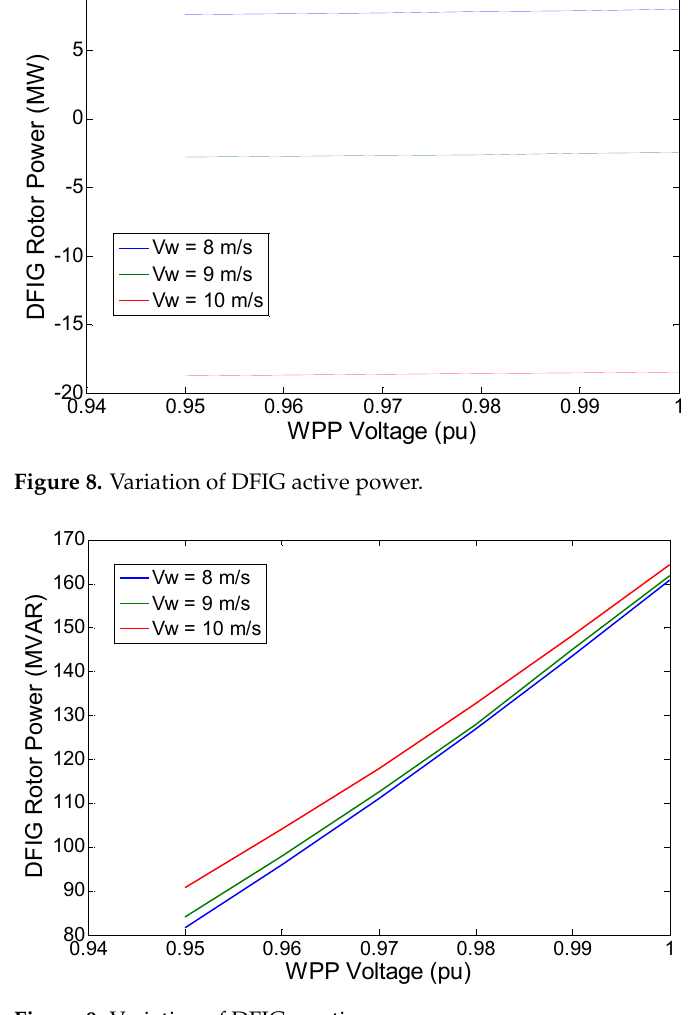
Figure 9. Variation of DFIG reactive power.